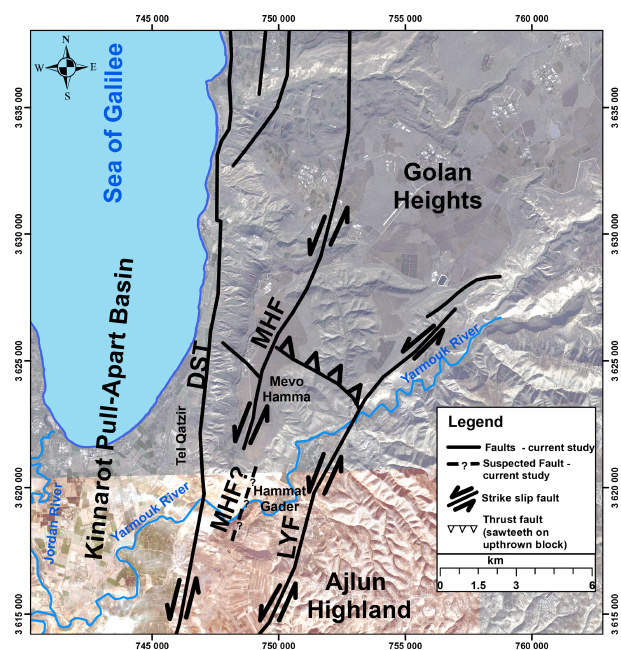
Figure 4. Results of the current study in a map local frame similar to the one used in Fig. 1. The proposed faults are in the area of the Lower Yarmouk Gorge, east of the Kinnarot pull-apart basin, Mevo Hamma Fault (MHF), and Lower Yarmouk Fault (LYF). It is suggested that those faults result from the settings at the eastern rim of the DST at the Golan Heights where the en-echelon changes from pull-apart basins to a push-up ridge at Mt. Hermon (Fig.